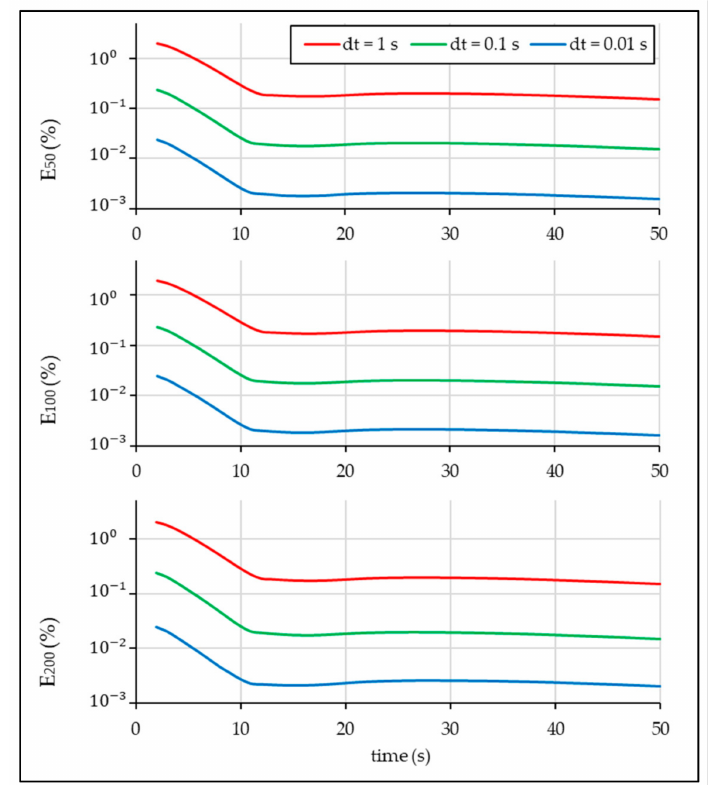
Figure 4. Time step induced error distribution for the three